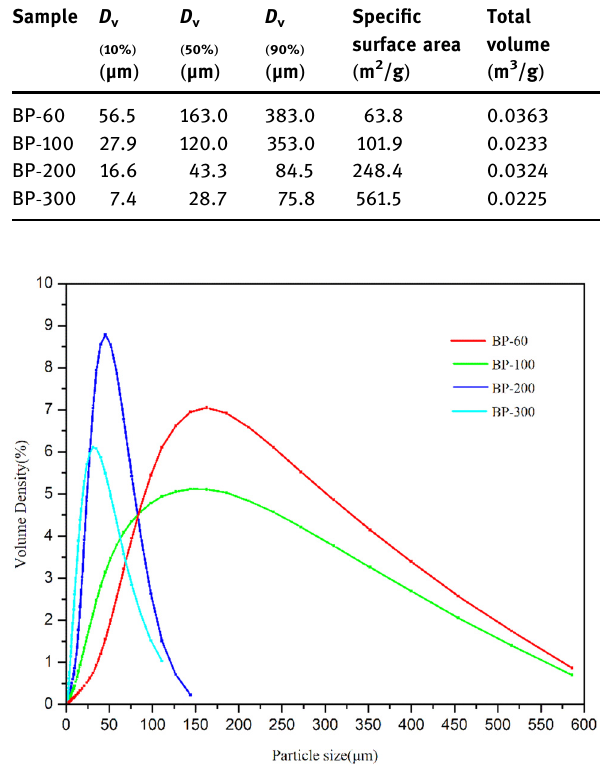
Figure 2: Particle size distribution of